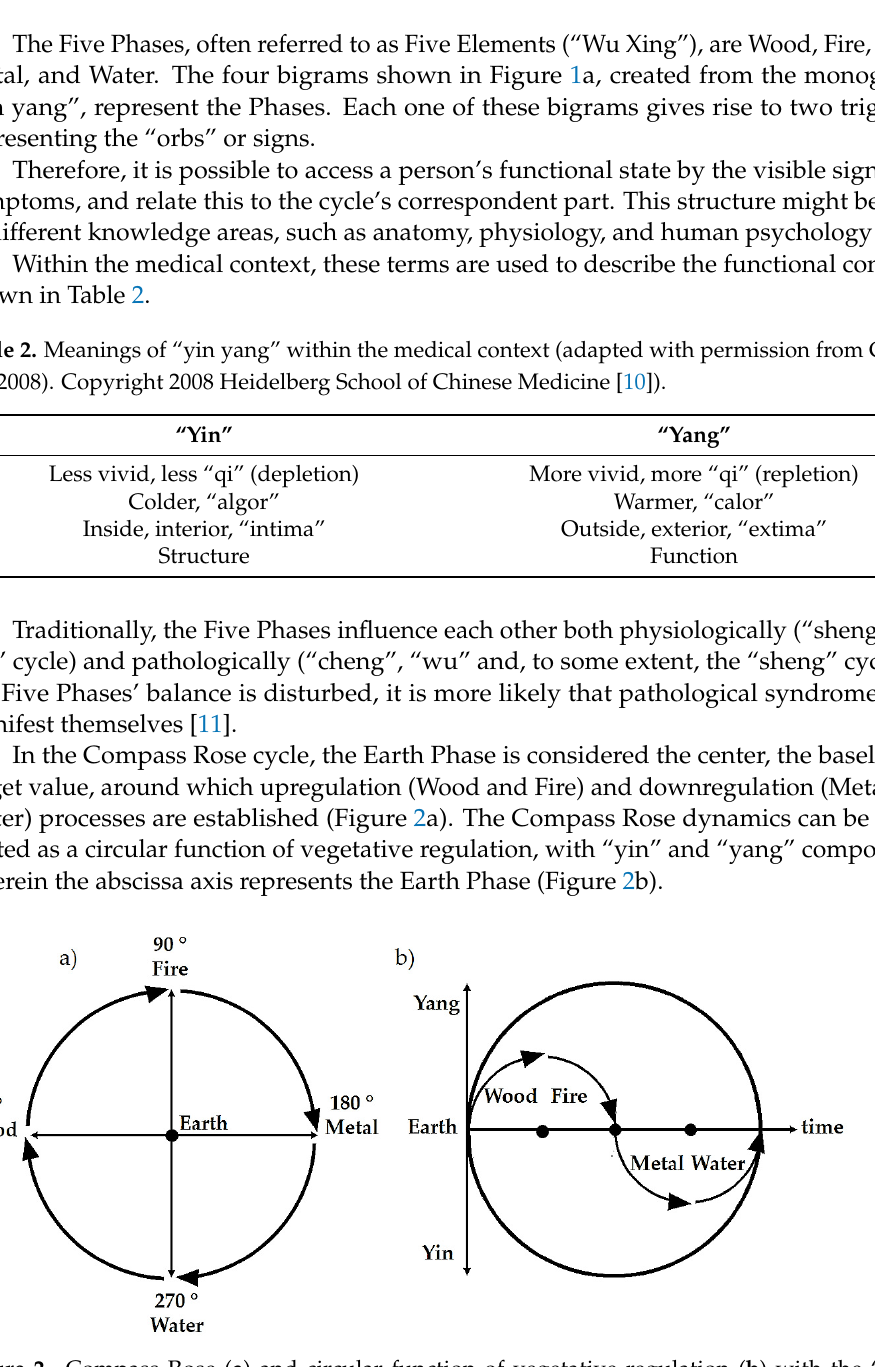
Figure 2. Compass Rose ( a ) and circular function of vegetative regulation ( b ) with the “yang” (upregulation) and “yin” (downregulation) components and respective Phases.